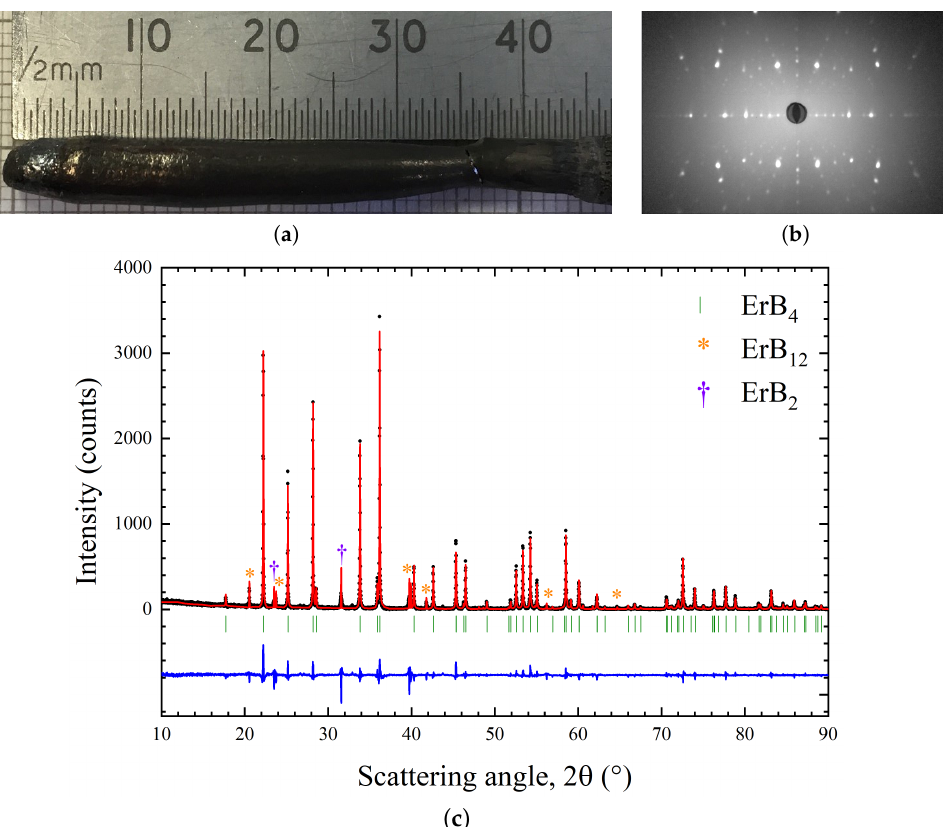
Figure 10. ( a ) Boule of ErB 4 prepared by the floating-zone method in an argon atmosphere at a growth rate of 10 mm/h. ( b ) X-ray Laue back reflection photograph of a crystal of ErB 4 , showing the [110] orientation of an aligned sample used for physical properties measurements. ( c ) Room temperature powder X-ray diffraction pattern of a ground ErB 4 crystal. The experimental profile (black closed circles) and a full profile matching refinement (red solid line) made using the P 4/ mbm tetragonal structure are shown, with the difference given by the blue solid line. The symbols * indicate the reflections belonging to an ErB 12 impurity and the † indicates an ErB 2